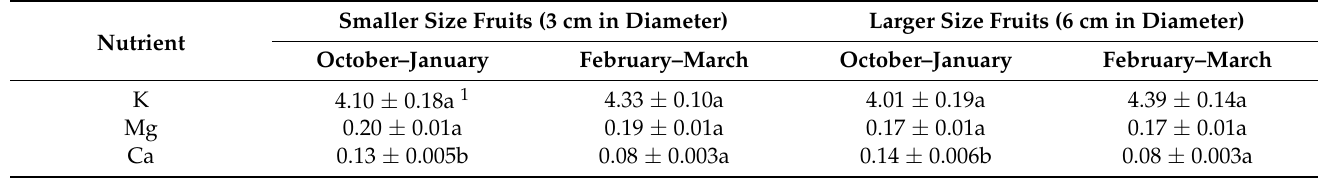
Table 6. Mean K, Mg, and Ca concentration (mass %, dry matter) in ‘Beorange’ tomato fruits in